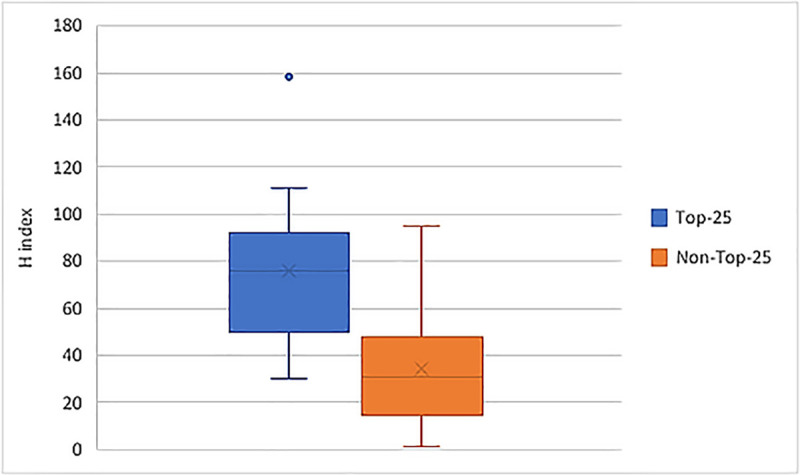
H-Index for Deans of Medicine for top-25 vs. non-top-25 medical schools.This figure depicts data from a study of Deans of U.S. Schools of Medicine (95 of 153 total whose CVs were available for review). When comparing Deans at Top-25 Medical Schools versus Deans of other schools, based on U.S. News & World Report’s 2019 research school ranking, Deans of Top-25 research-ranked medical schools had significantly higher H-indices (mean (SD): 73.1 (32.3) vs. 33.5 (22.5), t-test, p<0.001) than non-Top-25 Deans.